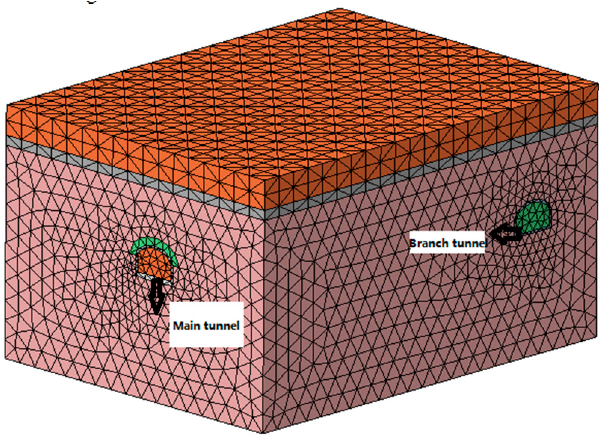
Figure 5. Numerical model grid.